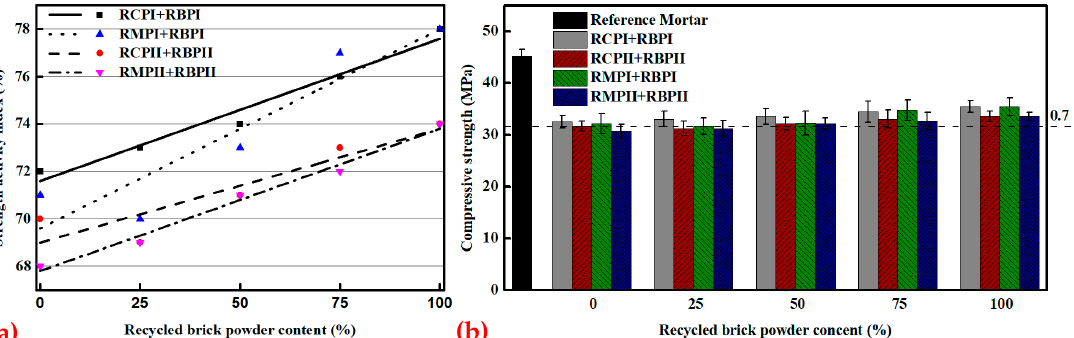
Figure 14. The results of the SAI experiment: ( a ) SAI, ( b ) compressive strength of mortar mixed with RP.